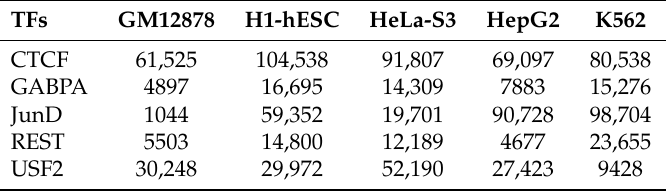
Table 5. The number of TFBSs for the five TFs in the five cell types.